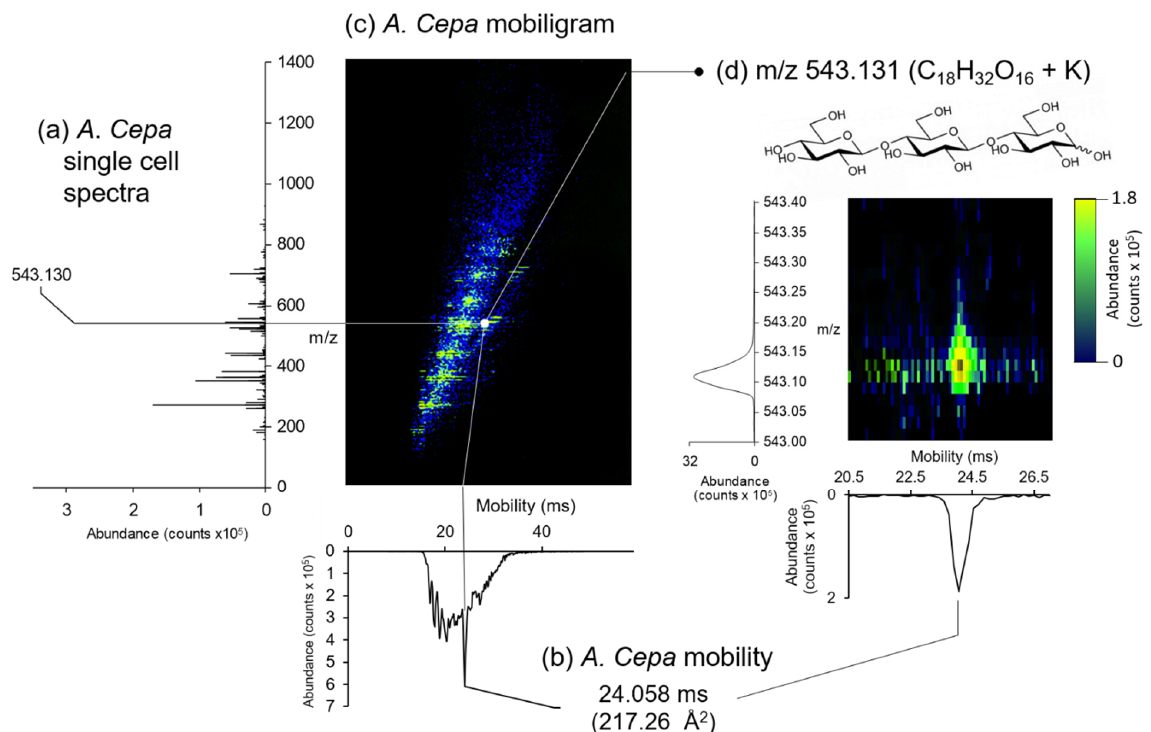
Figure 3. Example LAESI-DTIMS analysis of a single A. Cepa cell. ( a ) Spectrum with the saccharide peak labeled, ( b ) the corresponding mobility graph, and the ( c ) mobiligram showing detected species (green/yellow). ( d ) Spectrum and mobility graph of m / z 543.131 (C 18 H 32 O 16 + K, Trisaccharide) with corresponding mobiligram.